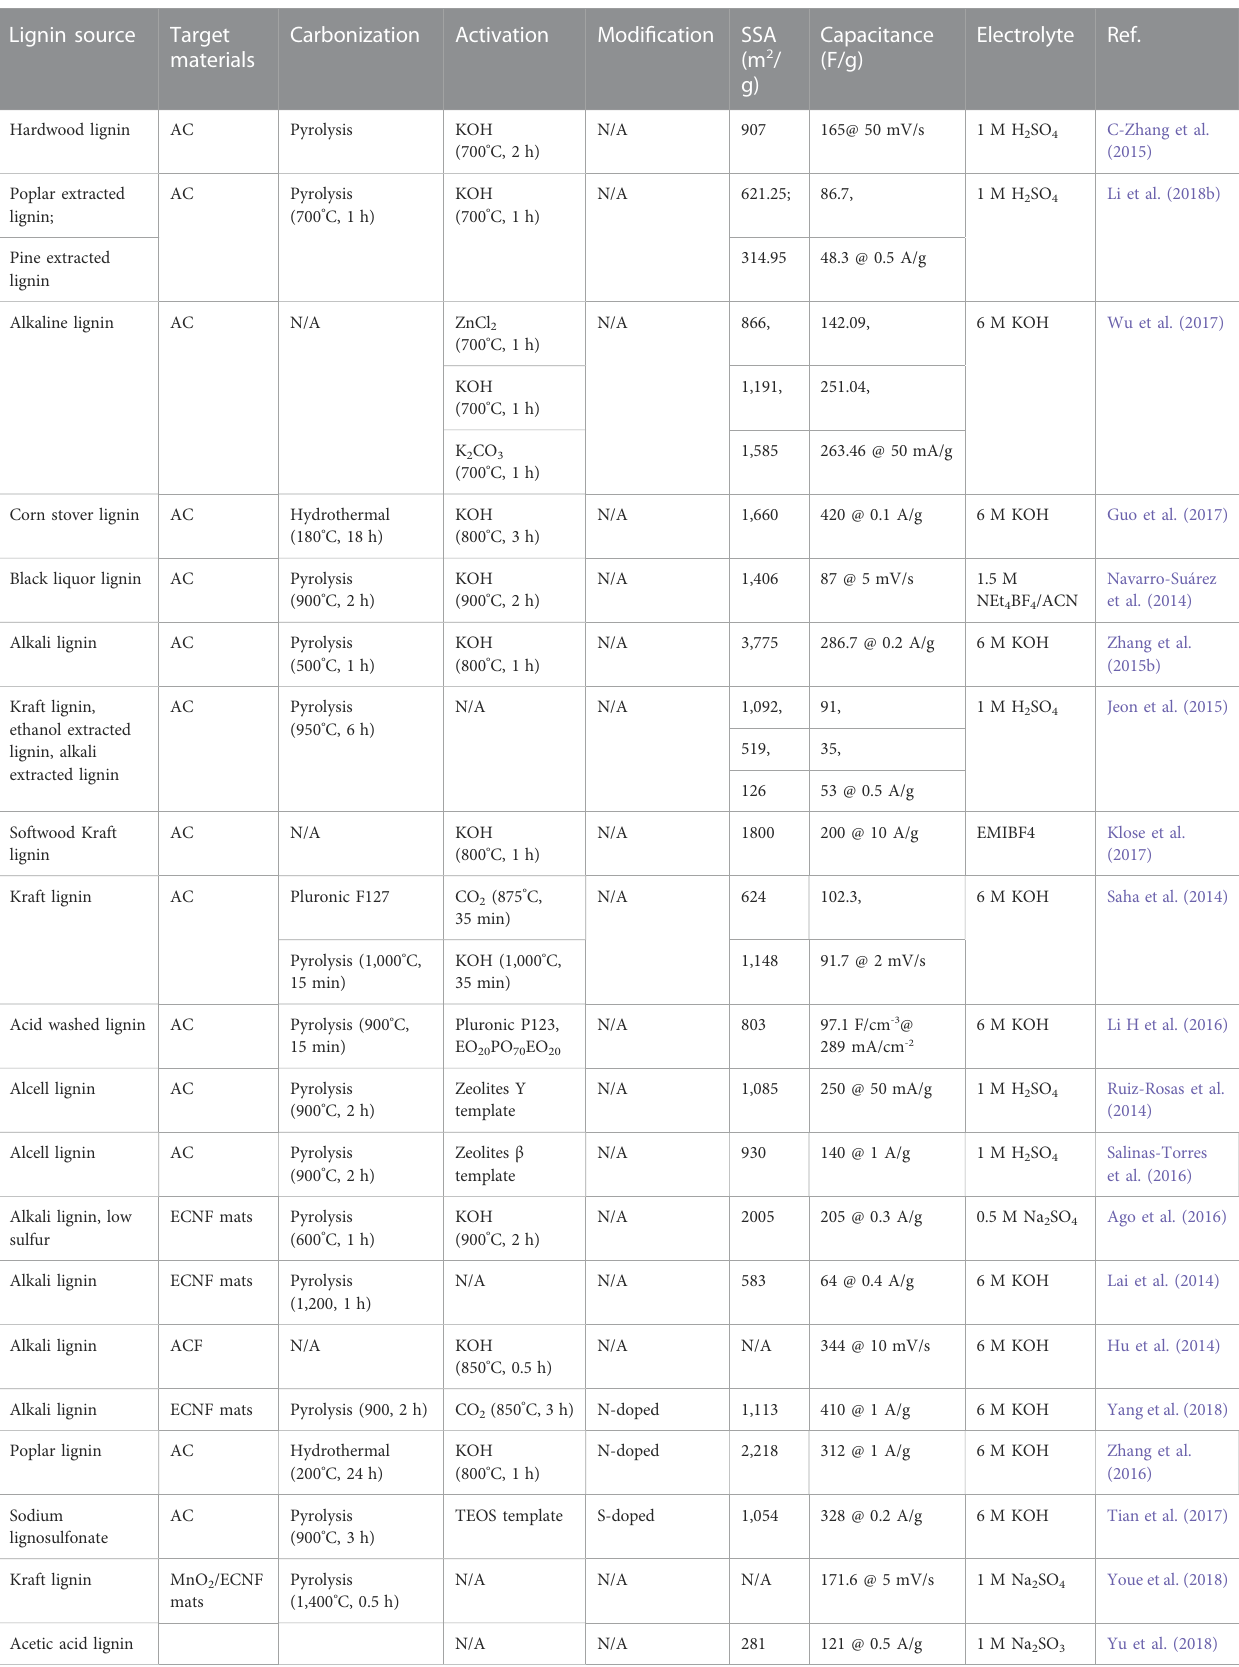
TABLE 1 Summary of lignin-derived carbon materials for supercapacitor